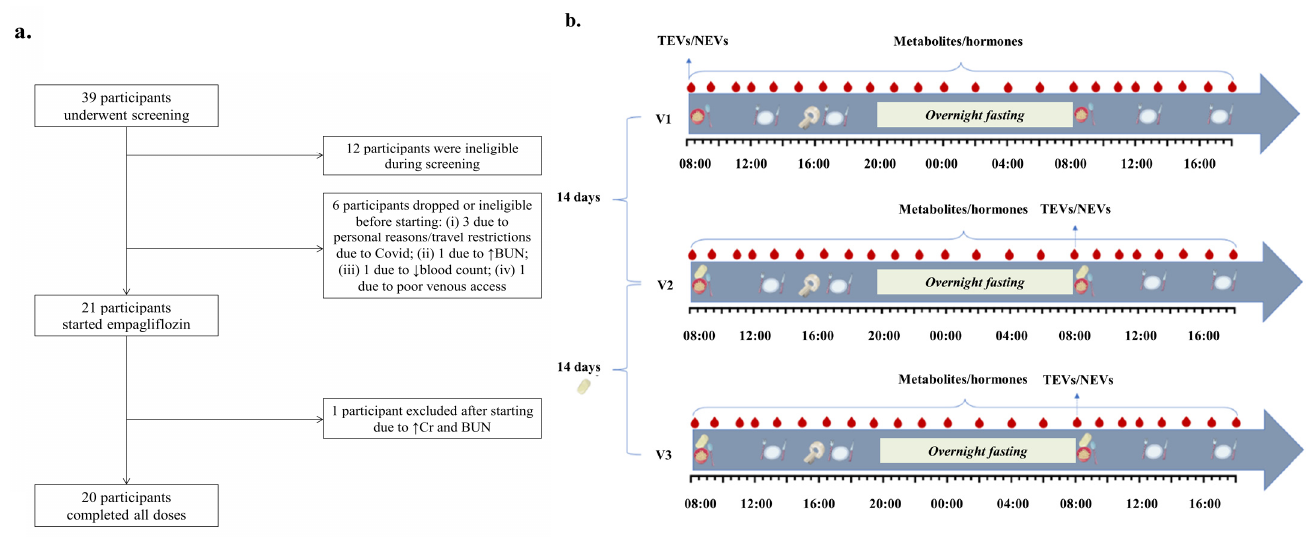
Figure 1. ( a ) . Flowchart of study population; ( b ) . Study procedures include: fasting blood draws for isolation of EVs (visit 1 t o , visit 2 t 24 and visit 3 t 24 ); empagliflozin administration from visit 2 to